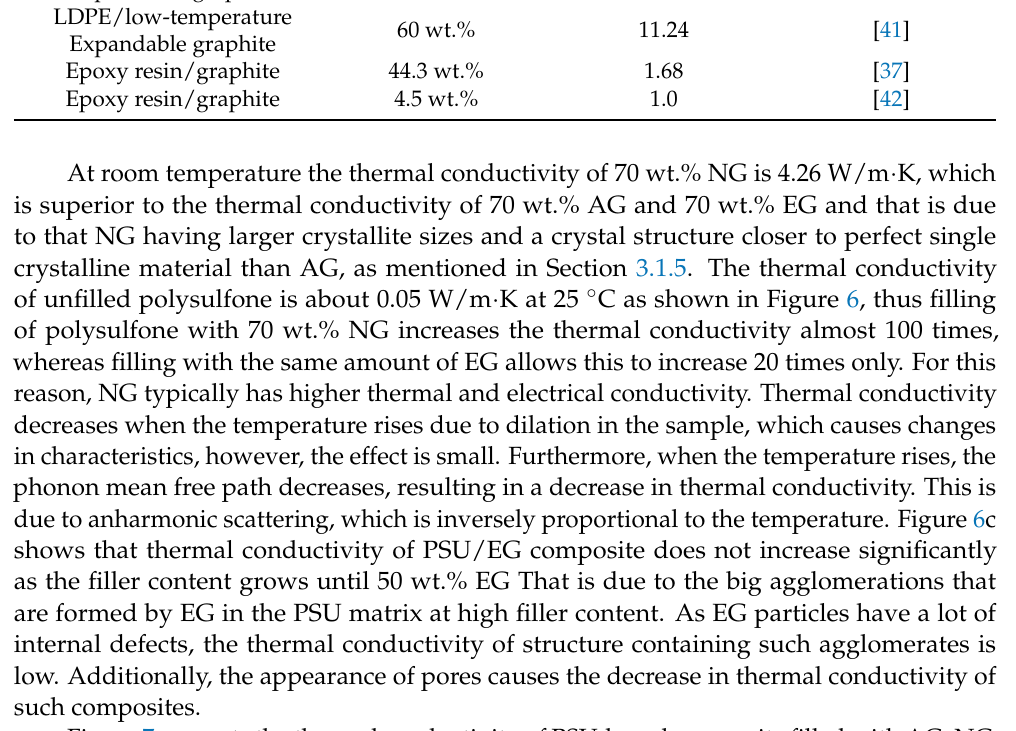
Table 2. Thermal conductivity of graphite composite based on preview studies. Thermal Reference Composite Filler Content Conductivity W/m · K LDPE/graphite 10 vol.% 6.5 [38] HDPE/graphite 7 wt.% 1.59 [39] LDPE/low-temperature 50 wt.% 7.02 [40] Expandable graphite LDPE/low-temperature 60 wt.% Expandable graphite